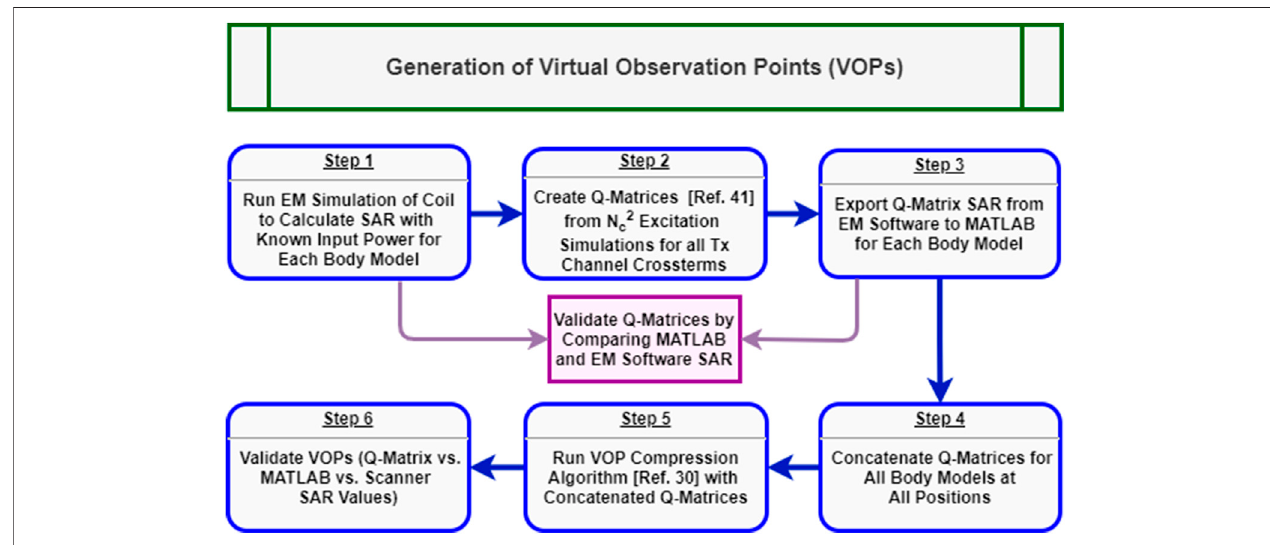
FIGURE4| GeneralizedworkflowforgenerationandvalidationofthevirtualobservationpointsforlocalSARmonitoringinpTx.Blueboxesrepresentchronological steps within the procedure while, purple boxes show feedback steps for additional EM simulations.